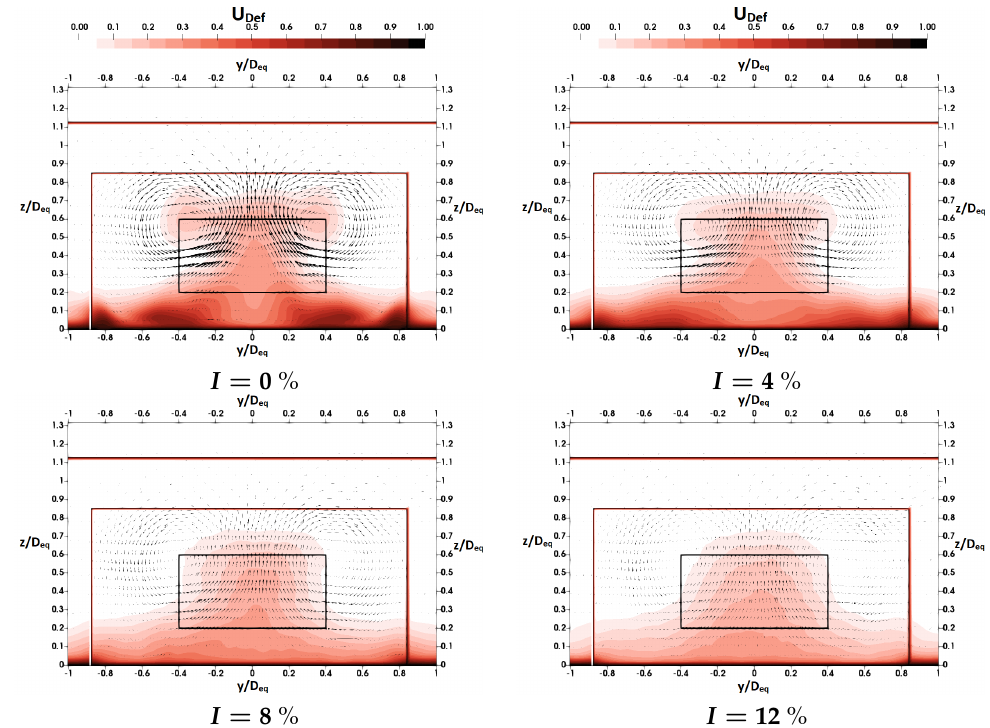
Figure 21. Contour of axial velocity deficit, 3.2 D eq downstream of the turbine. Velocity vectors are projected onto the plane. Turbine footprint is delimited in black. ALM-LBM simulations with four turbulence rates. U Def = 1 − < U x > / U ref